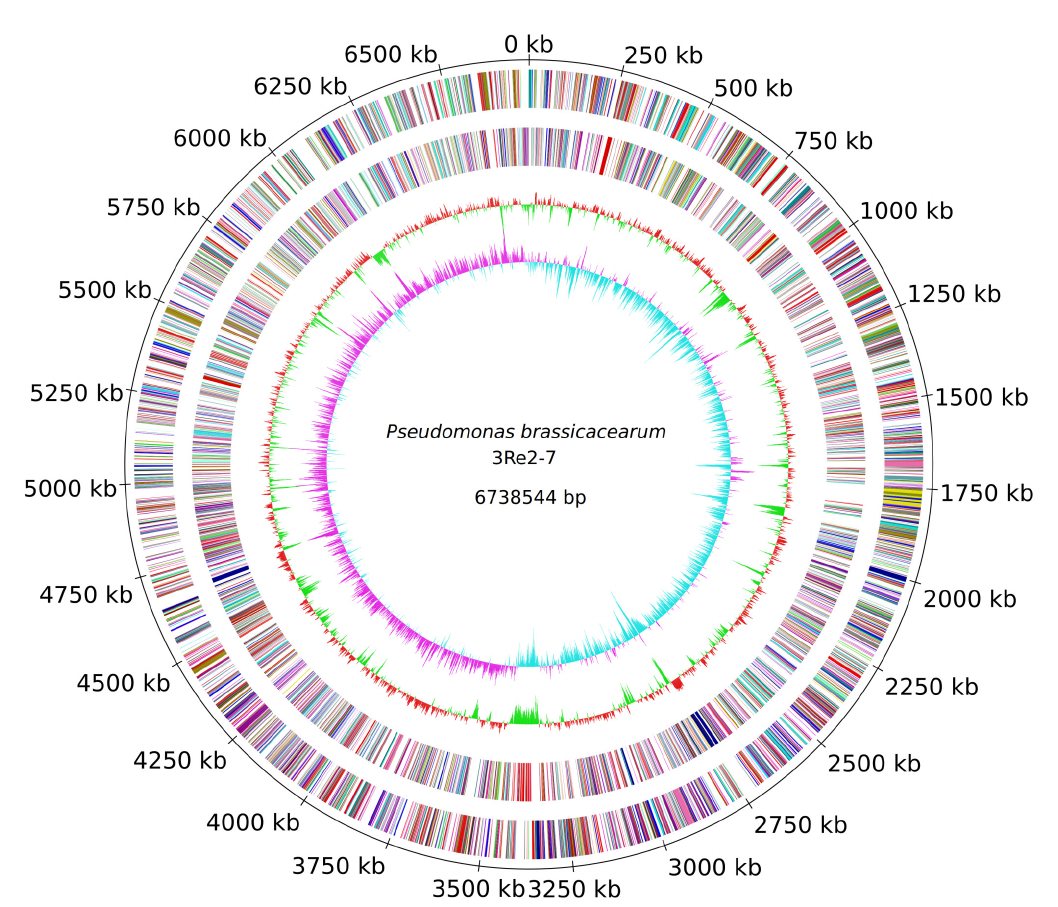
Figure 1. Circular representation of the P. brassicacearum 3Re2-7 chromosome. From the outer to the inner concentric circle: Circle 1, genomic position in kb (total 6,738,544 bp); the replication initiation gene dnaA was selected as first gene of the circular chromosome. Circles 2 and 3, predicted protein-coding sequences (CDS) on the forward [transcribed clockwise] (outer part) and the reverse [transcribed counter clockwise] (inner part) strand colored according to the assigned COG classes. Circle 4, GC content showing deviations from the average. Circle 5, GC